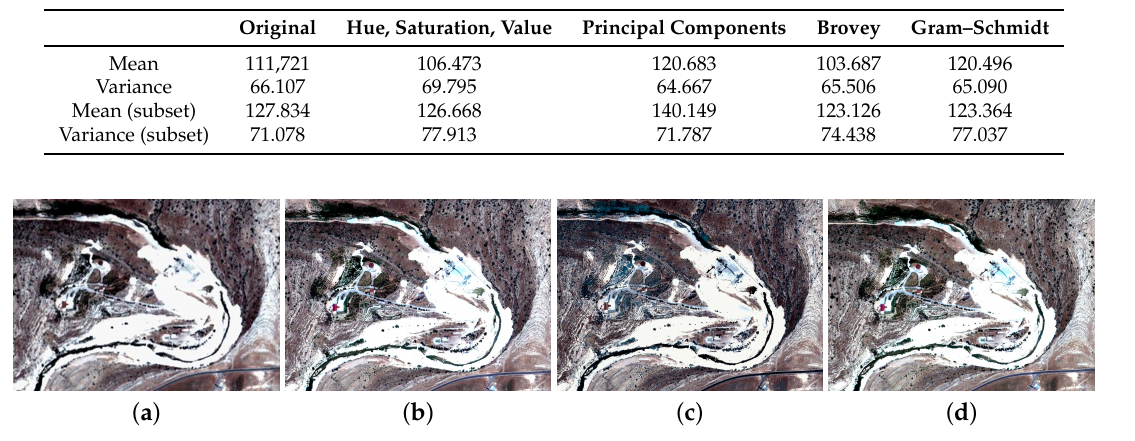
Table 1. Comparison of mean and variance for all images.